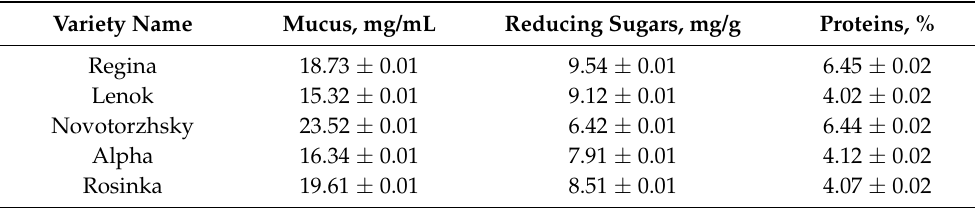
Table 2. Results obtained from the study of fiber flax seeds.